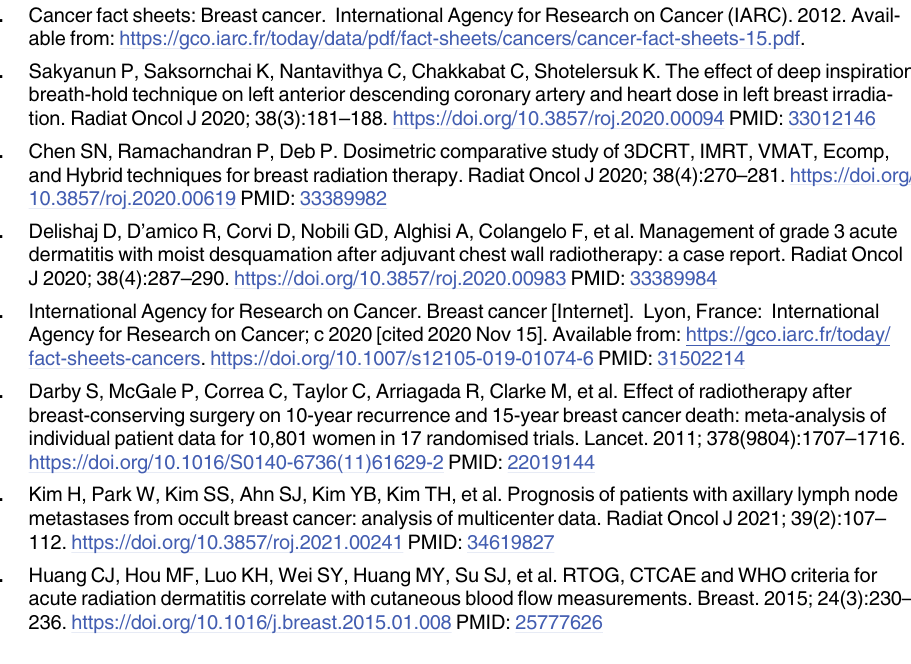
S1 Table. P -values of a two-way repeated measures analysis of variance (ANOVA) in the three imaging modes. (DOCX) S1 Data. Raw data for color space parameters.